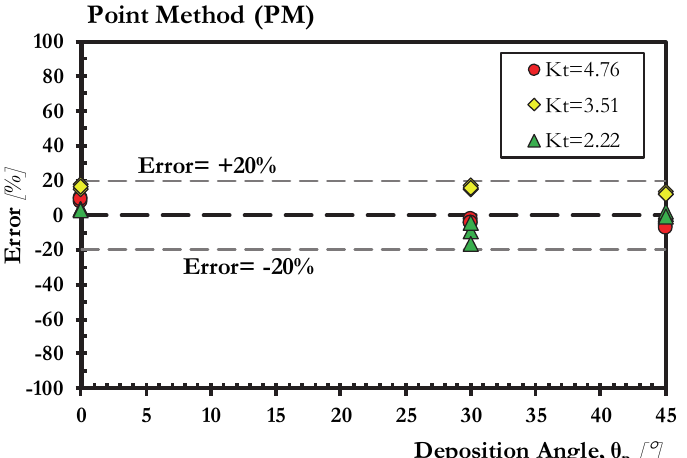
Figure 6: Overall accuracy of the TCD applied in the form of the PM in estimating static strength of additively manufactured PLA.